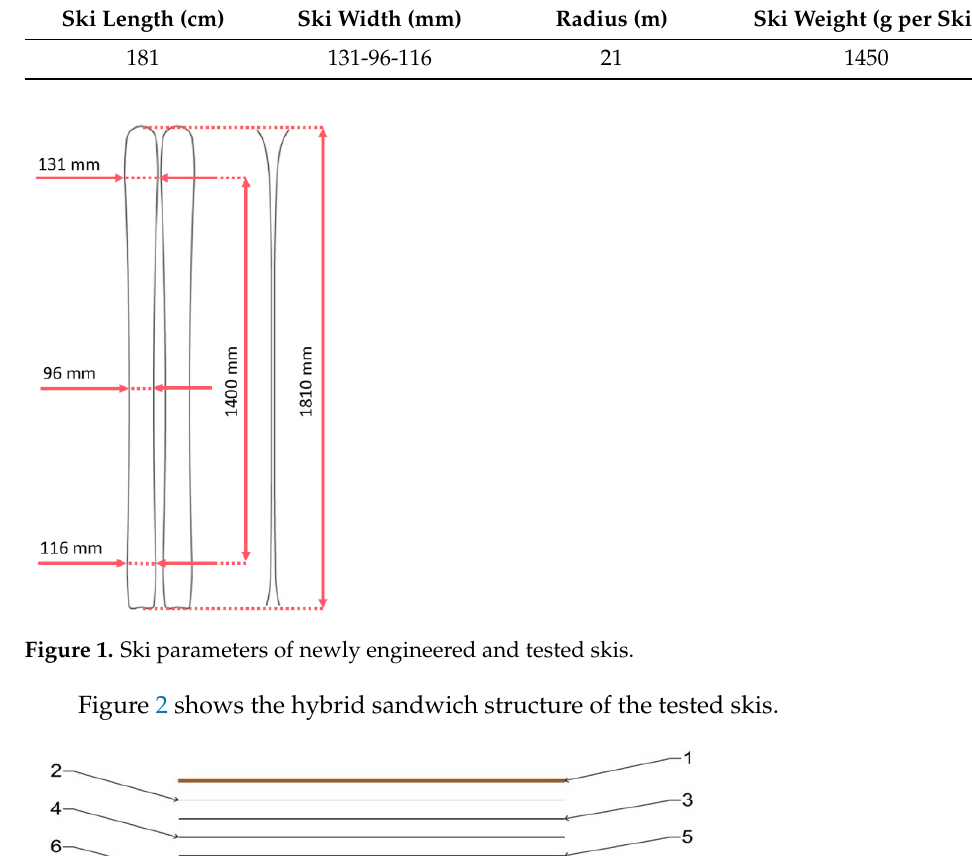
Table 2. Composition of materials in the ski structure.